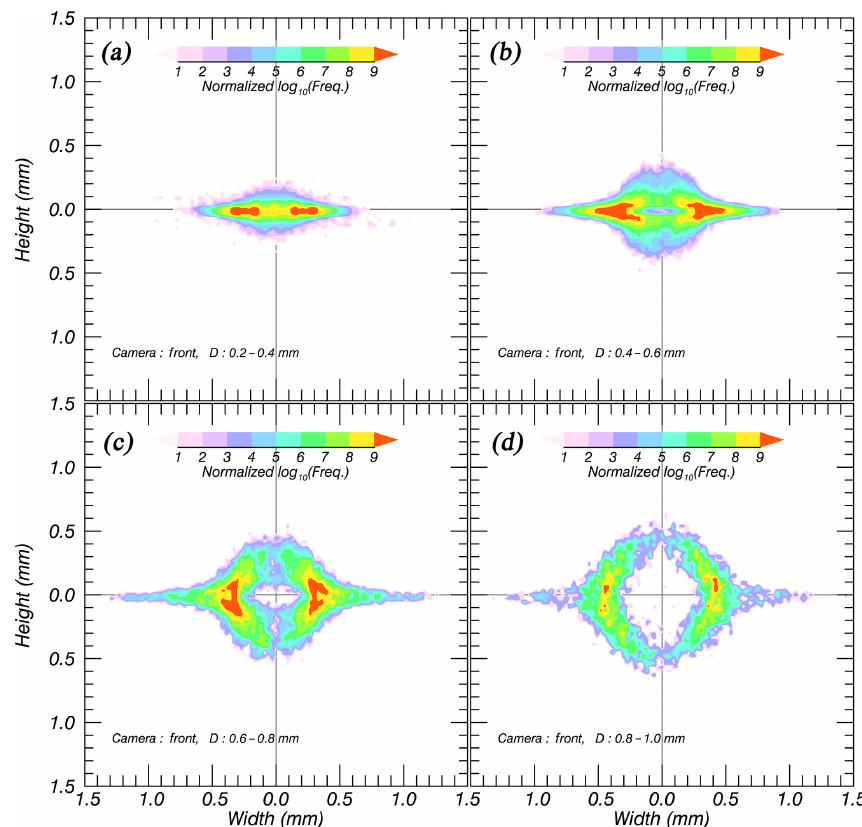
Figure 1. Accumulated contoured images of volcanic ash particles, with D measured by a two-dimensional video disdrometer (2DVD).